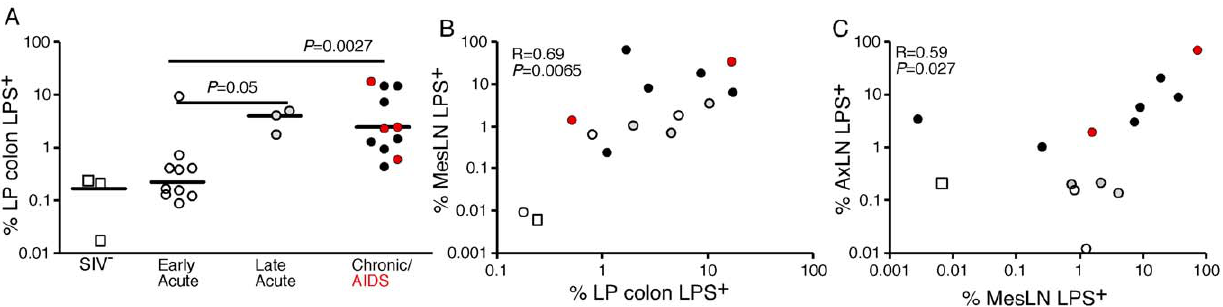
Figure 6. Quantitative image analysis of microbial translocation. ( A ) Levels of LPS within the LP of the colon of SIV-uninfected (white squares), early acute (white circles), late acute (gray circles), chronic Non-AIDS (black circles) and chronic AIDS (red circles) RMs. Mann-Whitney U test performed between the chronically infected (both Non-AIDS and AIDS) and early acute RMs and between late acute and early acute RMs. ( B ) Correlation between LPS levels within the LP of the colon and the mesenteric LN for animals in which we had obtained both colon and MesLN samples. Significance determined using Spearman’s rank correlation coefficient and associated p-value shown. ( C ) Correlation between LPS levels within MesLN and AxLN for animals in which we hadobtained both MesLNand AxLN samples. Significance determined using Spearman’s rank correlation coefficient and associated P-value shown.